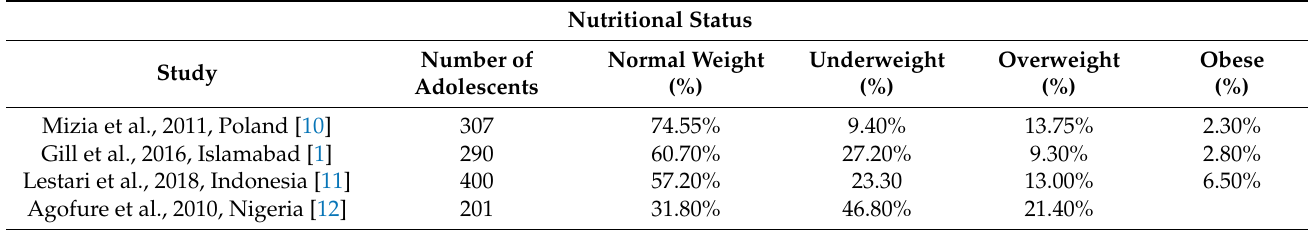
Table 4. Nutritional status of adolescents included in other